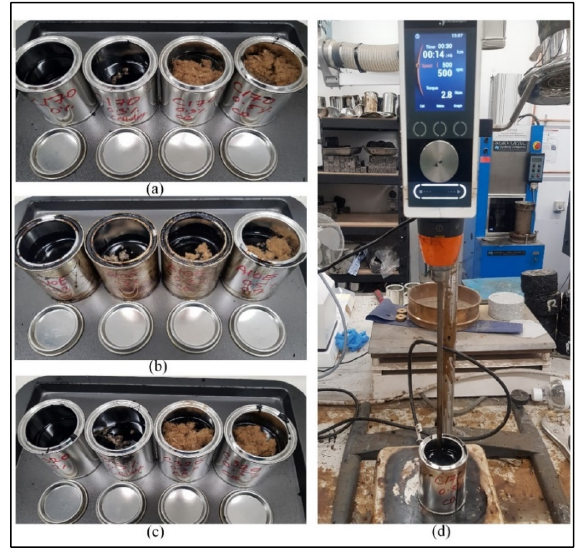
Figure 6. ( a ) Bitumen C170, ( b ) Bitumen A10E, ( c ) Bitumen C320, and ( d ) blending of bitumen with fibers using the shear mixture.